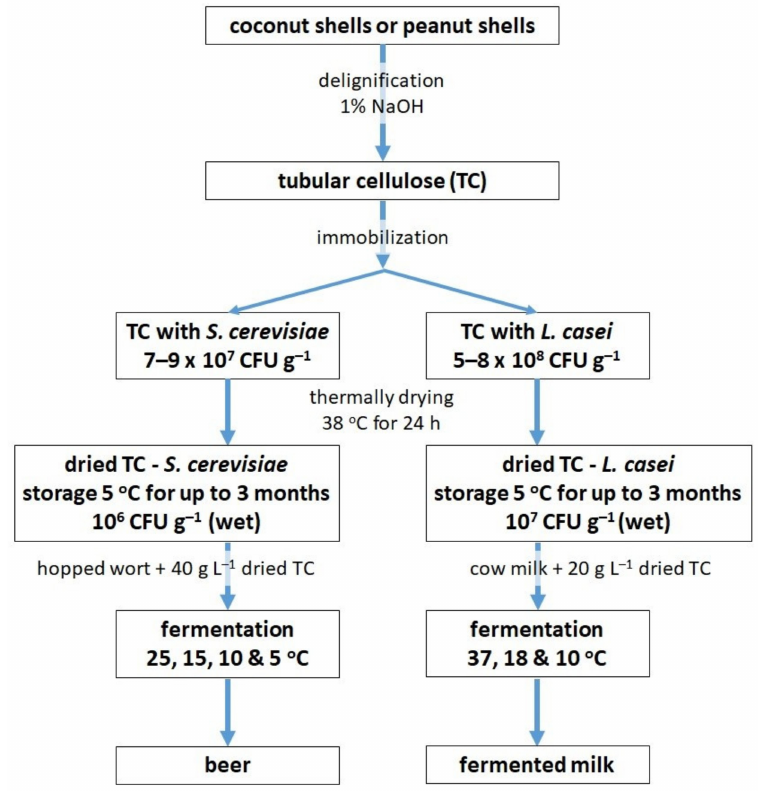
Figure 1. The production of beer and fermented milk with tubular